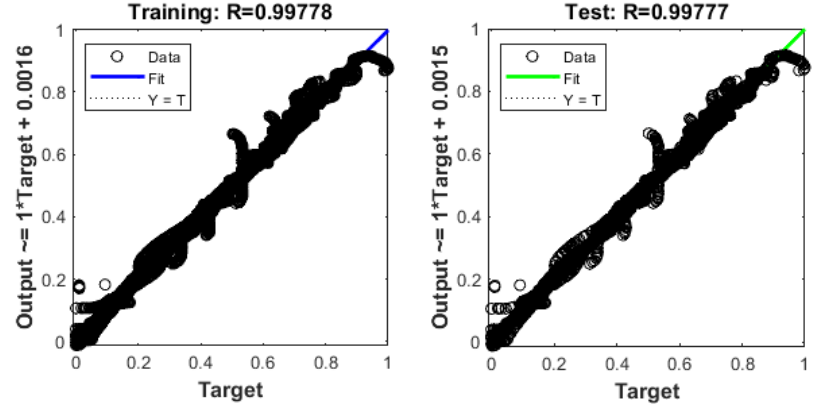
Figure 6. Training and test R values for one hidden layer MLA.